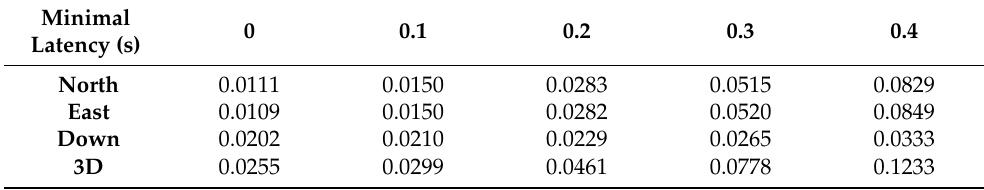
Table 5. RMSE with different minimal latencies of raw GNSS observations in mode 3.